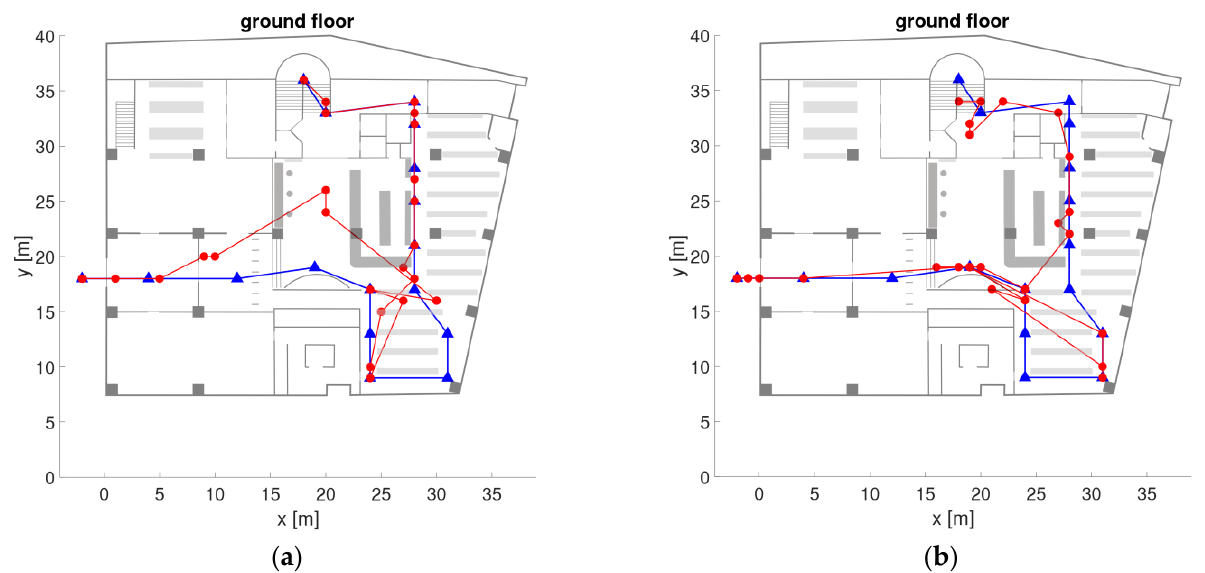
Figure 17. Trajectories of two measurement runs on the ground floor with estimated positions in red and ground truth in blue. ( a ) worst result; ( b ) good result.